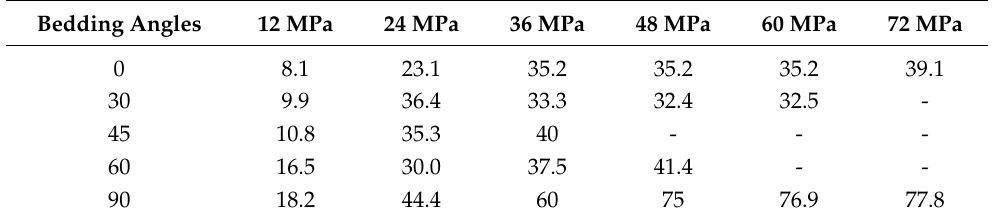
Table 9. Instantaneous elastic modulus of rock samples in a natural state at different stress levels. Bedding Angles